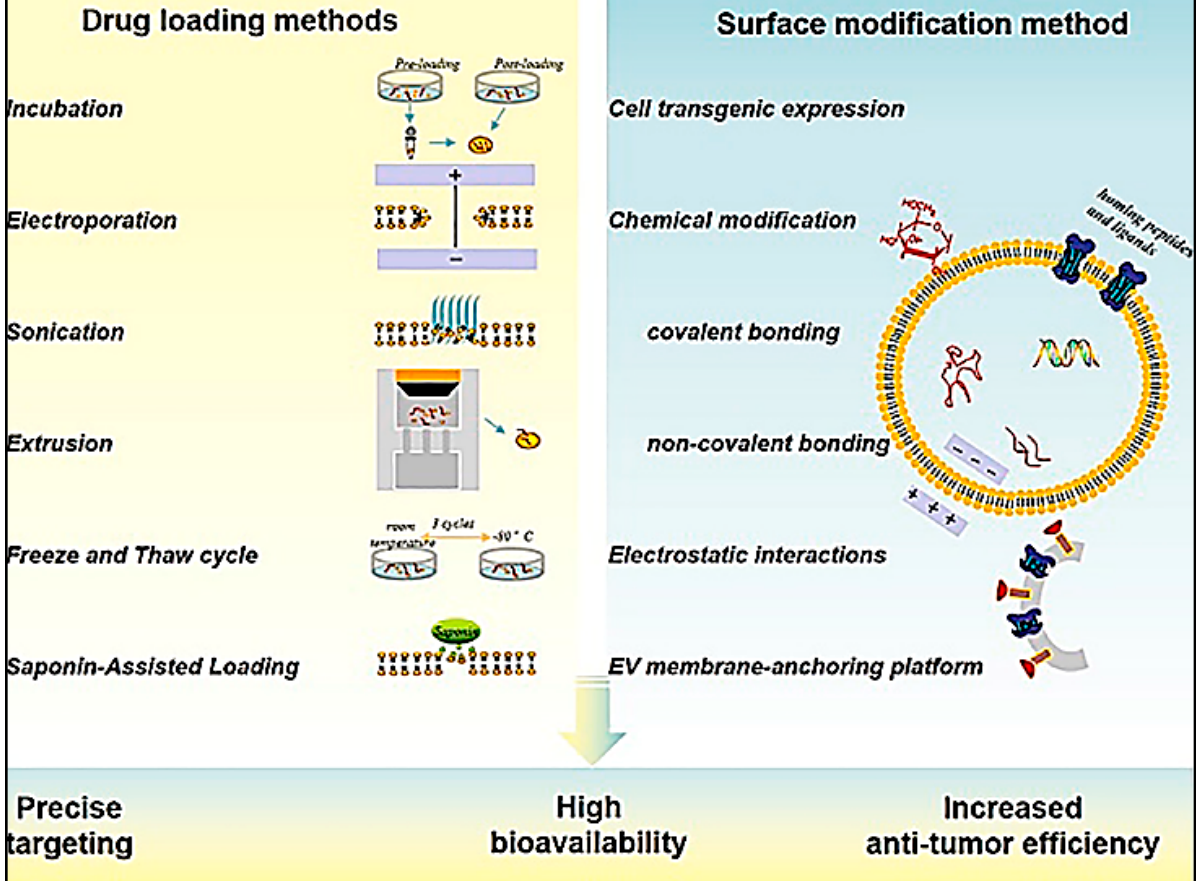
Figure 7. Schematic representation of drug loading of exosomes through the use of culturing, electroporation, sonication, extrusion, freeze-and-thaw cycles, and saponin-assisted loading. Exosome surface modification through chemical alteration, electrostatic interaction, and EV membrane for enhanced targeting efficiency to cancer cells [110]. Reproduced with permissions from Ya-Nan Pi et al., Biochemical Pharmacology , Elsevier,